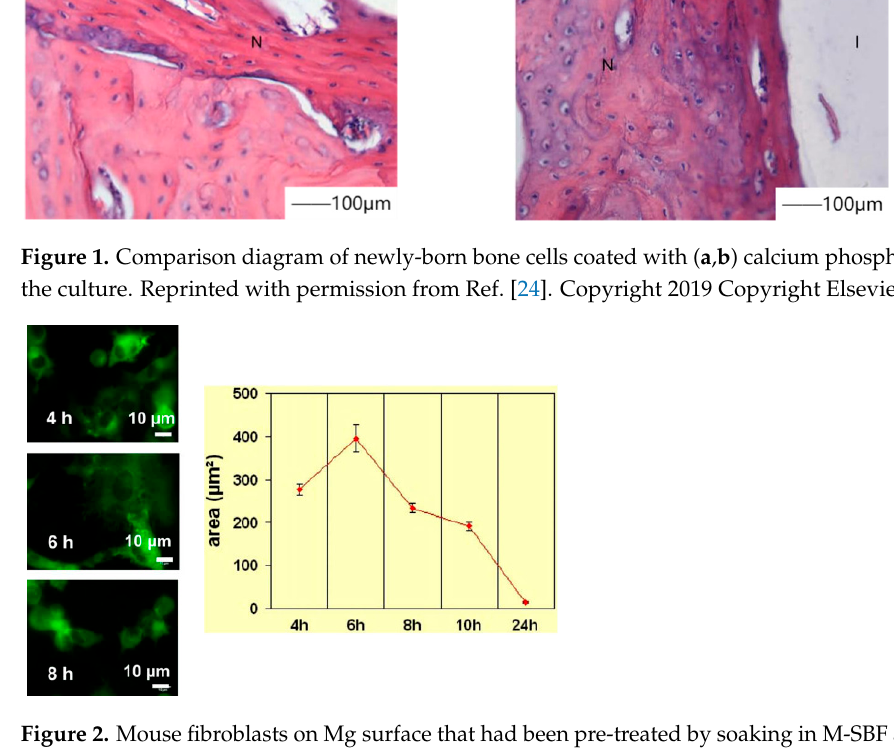
Figure 2. Mouse fibroblasts on Mg surface that had been pre-treated by soaking in M-SBF at 37 °C for 5 days. Fluorescence imaging of cells and cell spreading area as a function of culture time. Reprinted with permission from Ref. [25]. Copyright 2009 Copyright Elsevier.